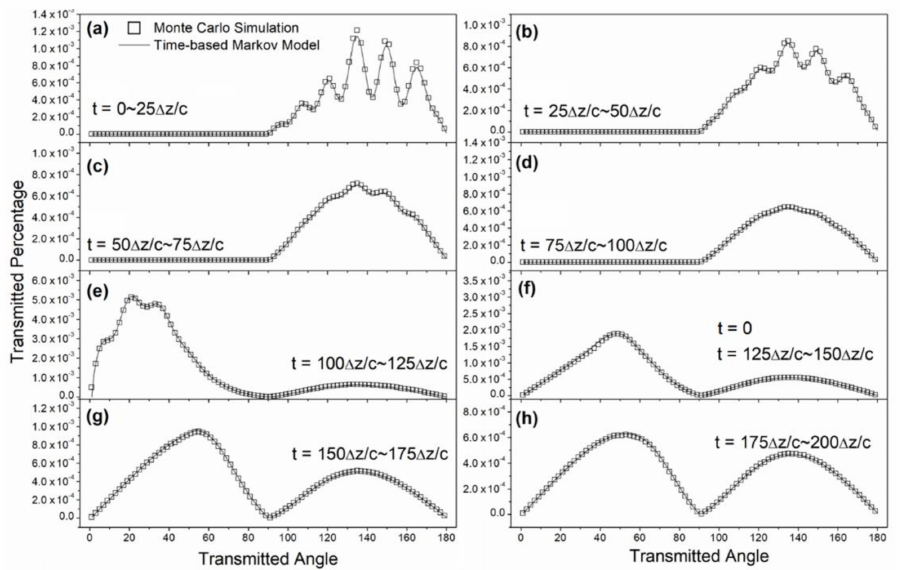
Figure 4. Time-based Markov chain model predictions compared with the Monte Carlo simulation results. ( a – h ) Photons transmitted within different ranges of